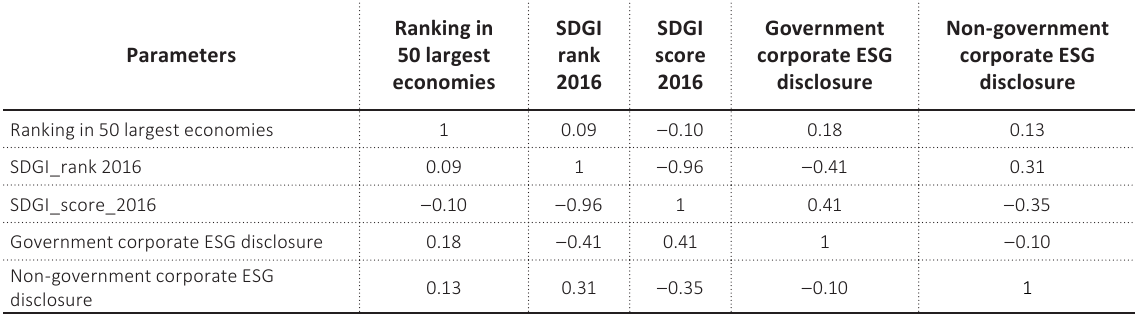
Table D3. Correlation analysis of ESG disclosure regulation and rankings: case of developing and emerging